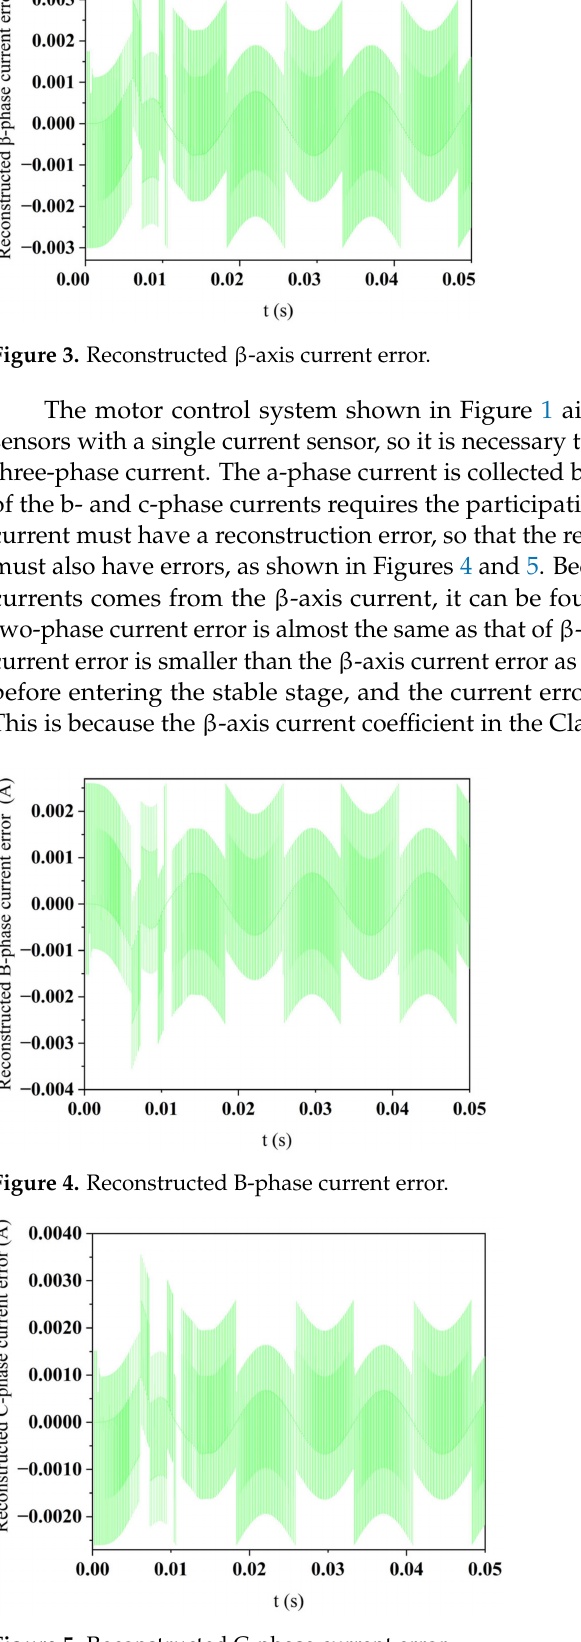
Figure 5. Reconstructed C-phase current